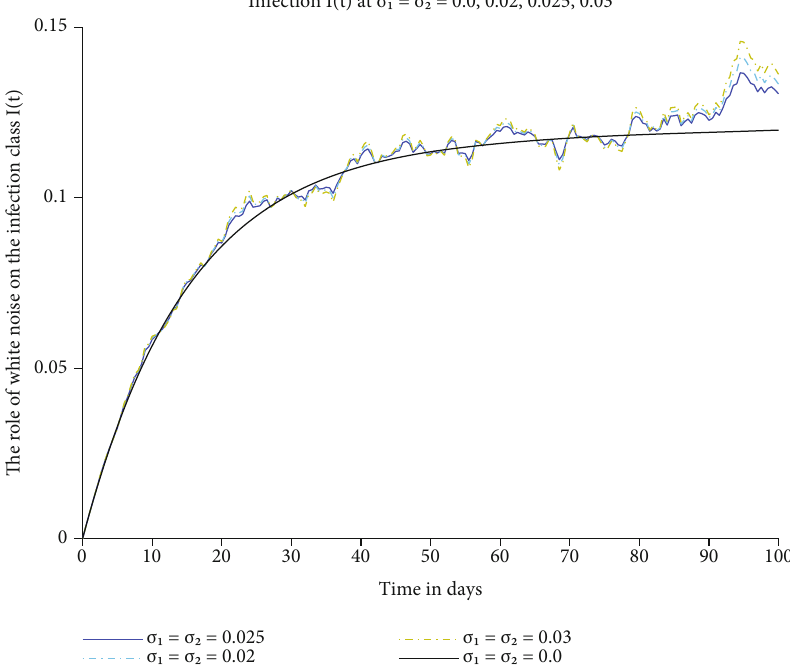
Figure 2: Joint solution of the given model (1) of COVID-19 for the order